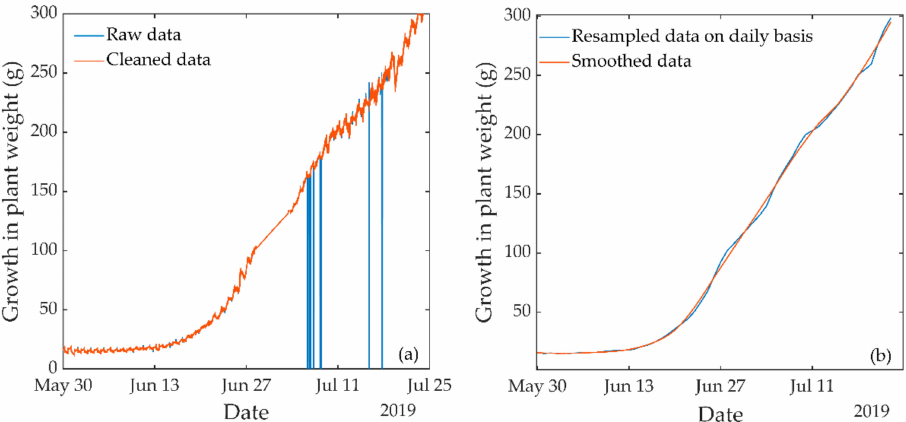
Figure 4. Sample preprocessing of observation data from sensor 14: ( a ) the original data were cleaned of unreliable records using the Hampel Identifier and reconstructed using the moving average method; ( b ) the cleaned data were then resampled on a daily basis and smoothed using the Savitzky–Golay